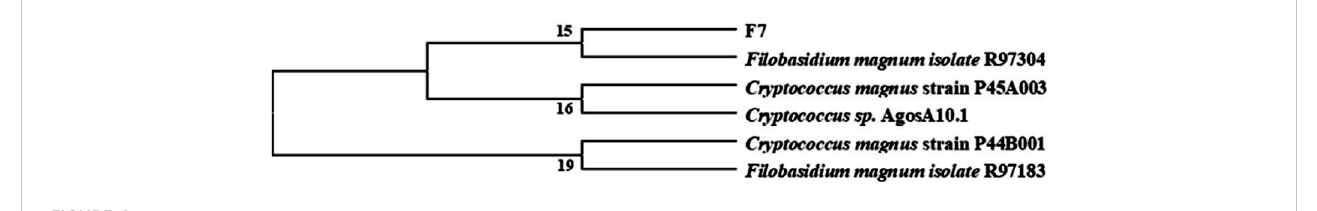
FIGURE 4 Phylogenetic tree of F. magnum F7#.